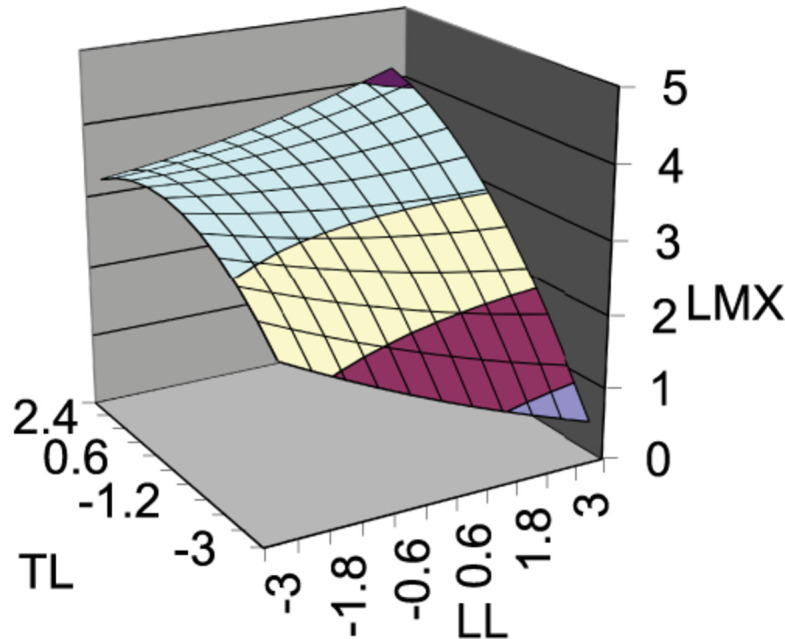
Response surface.